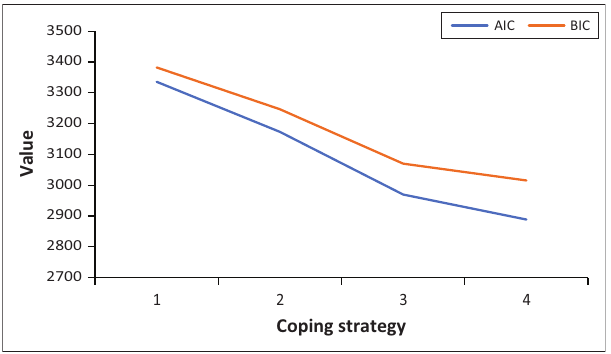
AIC, Akaike information criterion; BIC, Bayes information criterion. FIGURE 1: Plots of the Akaike information criterion and the Bayes information criterion values.